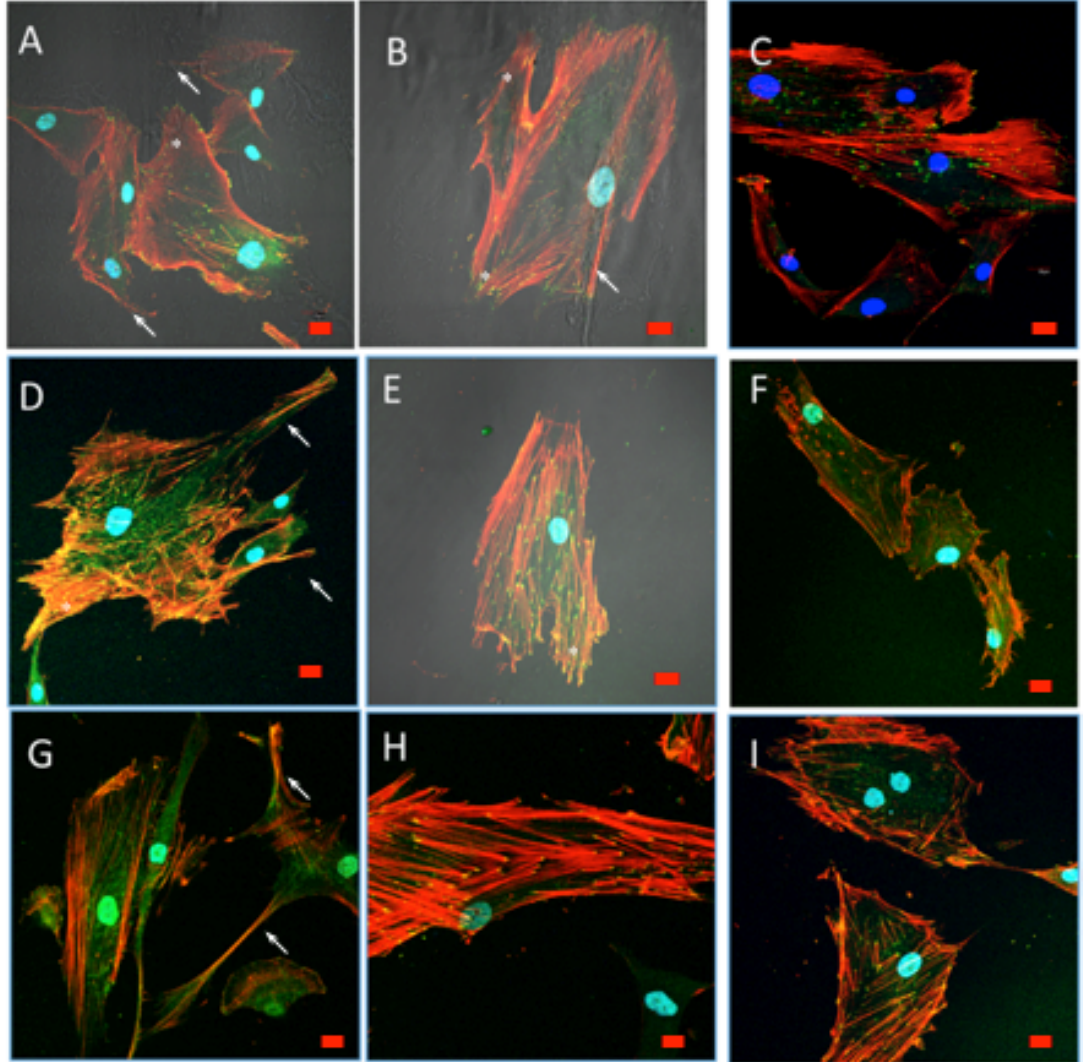
Figure 10. HOB ® osteoblasts grown on CS10G4 sample after 48 h ( A , B ), 72 h ( D , E ) and 1 week ( G , H ) in culture, and examined with confocal microscope (40× objective lens). Osteoblasts grown on glass were used as reference control, shown in ( C ), for 48 h in culture, ( F ) after 72 h in culture and ( I ) after 1 week. In red, rhodamine–phalloidin immunolabelled actin cytoskeletal fibers, showing polarization to material and actin cytoskeletal arrangement into stress fibers. Focal adhesions (yellow) were immunolabelled with antivinculin antibody. Nuclei (blue) were DAPI labelled. Arrow marks filopodial emissions, star marks lamellipodia. Scale bar represents 20 µm.